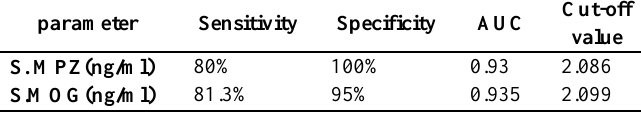
Table 5 : Sensitivity and Specificity, area under curve and Cut-off